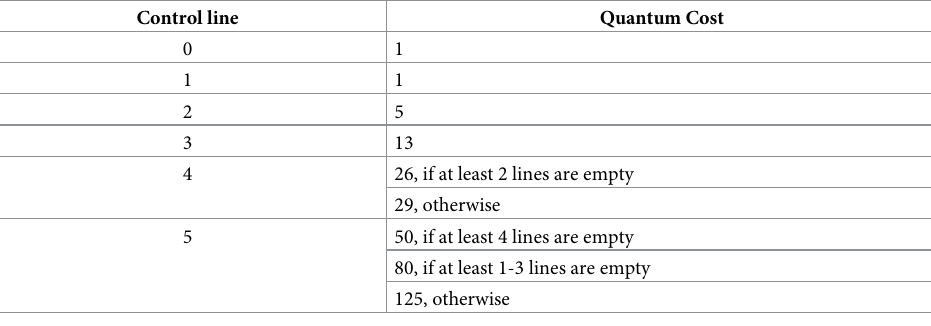
Table 3. Quantum costs of multiple control Toffoli